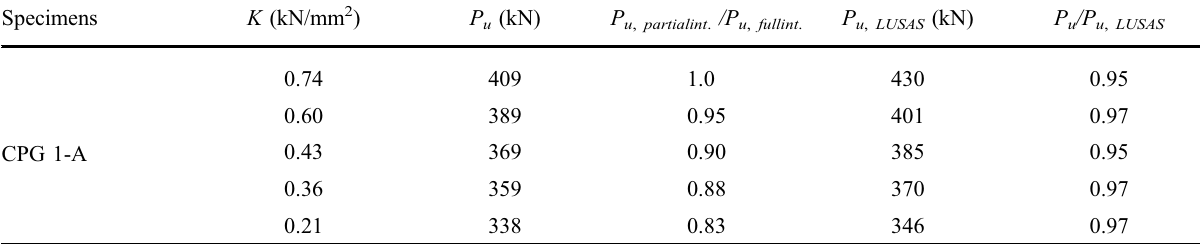
Table 4. Comparison of ultimate loads for girders under two concentrated loads